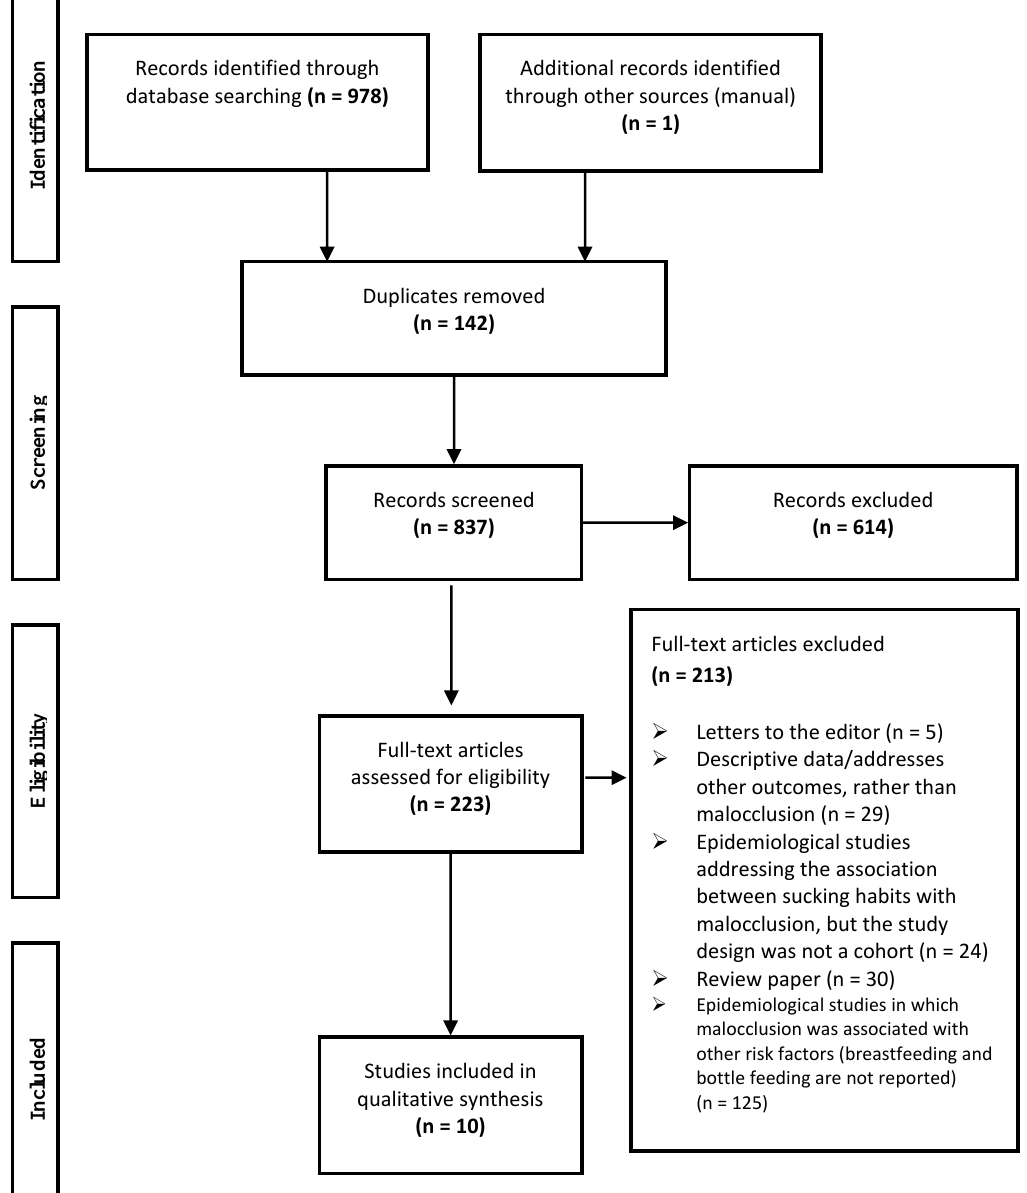
Figure 1. Screening of articles. Four-phase PRISMA flow-diagram for study collection, showing the number of studies identified, screened, eligible, and included in the review and